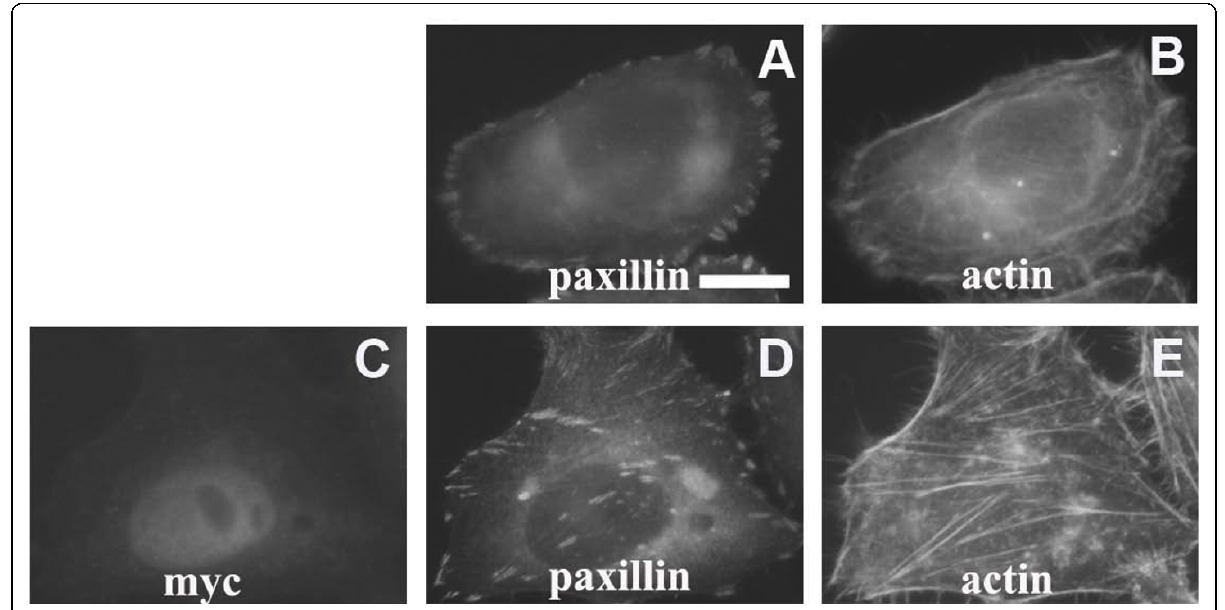
Figure 2 LKB1 promotes focal adhesion formation in HeLa-S3 cells . A.B . HeLa-S3 control cells stained with paxillin reveal small, peripheral focal complexes, which co-localize with cortical actin. C-E . Expression of myc-tagged LKB1 induces elongated focal adhesions throughout the cell body that decorate the ends of newly formed stress fibers. A fraction of overexpressed LKB1 protein is present at the cell membrane. Scale bar = 20 μ